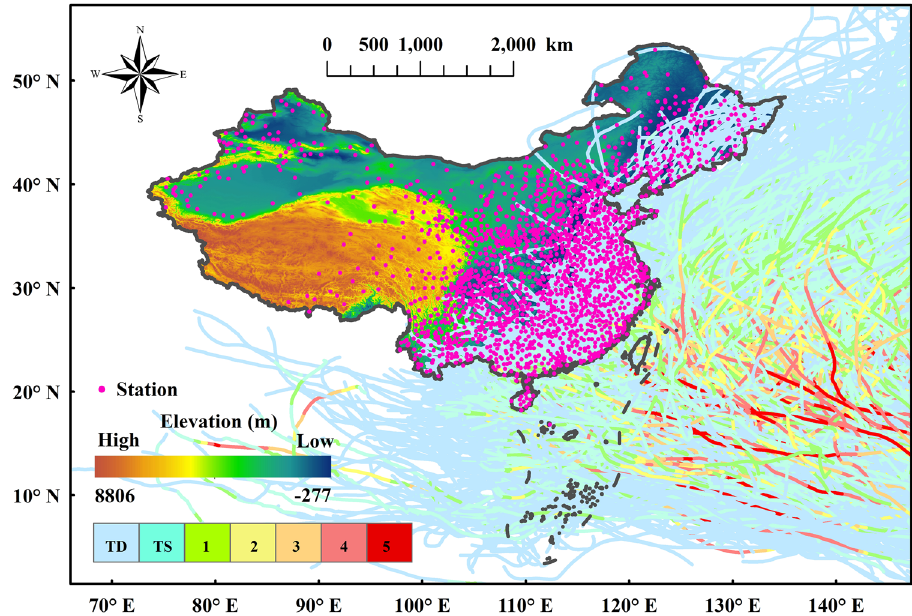
Fig. 2 Geographic locations of the selected 1937 weather stations (pink dots), the observed tropical cyclone (TC) tracks from 1960 to 2016 (colored lines), and the digital elevation model in China. The intensities of TCs are classified based on the Saffir-Simpson hurricane intensity